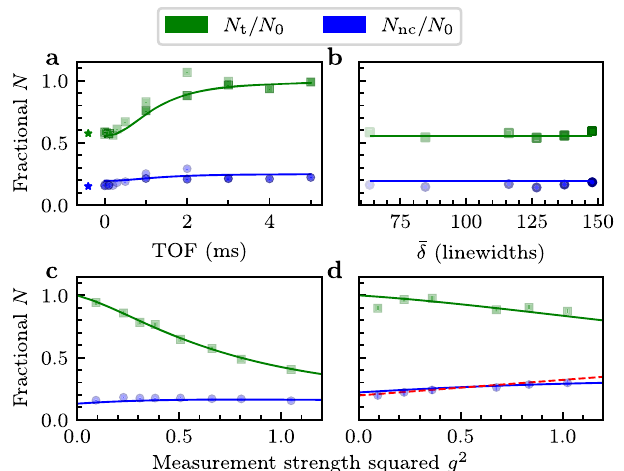
Fig. 5 Light-induced collisions. Fractional total number of atoms (green squares) and number of atoms outside the BEC but within a 1 recoil momentum circle (blue circles) following measurement. The symbols mark experimental data while the curves are the result of our 2-body model. In all cases, the opacity of the points re fl ects the detuning. a Dispersive measurements at two different probe detunings ( (cid:2) δ ¼ 84 : 5 and (cid:2) δ ¼ 126 : 7) after a variable short time-of- fl ight (TOF). All measurements were at measurement strength g ≈ 1, which was attained by adjusting intensity to (cid:2) I (cid:9) 9 : 5 and (cid:2) I (cid:9) 21 respectively. Star symbols mark in situ measurements with the optical dipole trap on (plotted at negative TOF for display purposes). b In situ measurements at different (cid:2) δ all with g ≈ 1. Measurement time was t m = 25 μ s in a and b . c , d Loss as a function of g 2 for measurements made in situ in c and with a 2 ms TOF in d . The red dashed line in d plots the expected g 2 /8 light-scattering behavior. Both cases were at (cid:2) δ ¼ 84 : 5 and (cid:2) I (cid:9) 9 : 5 with t m varied from 4 to 36 μ